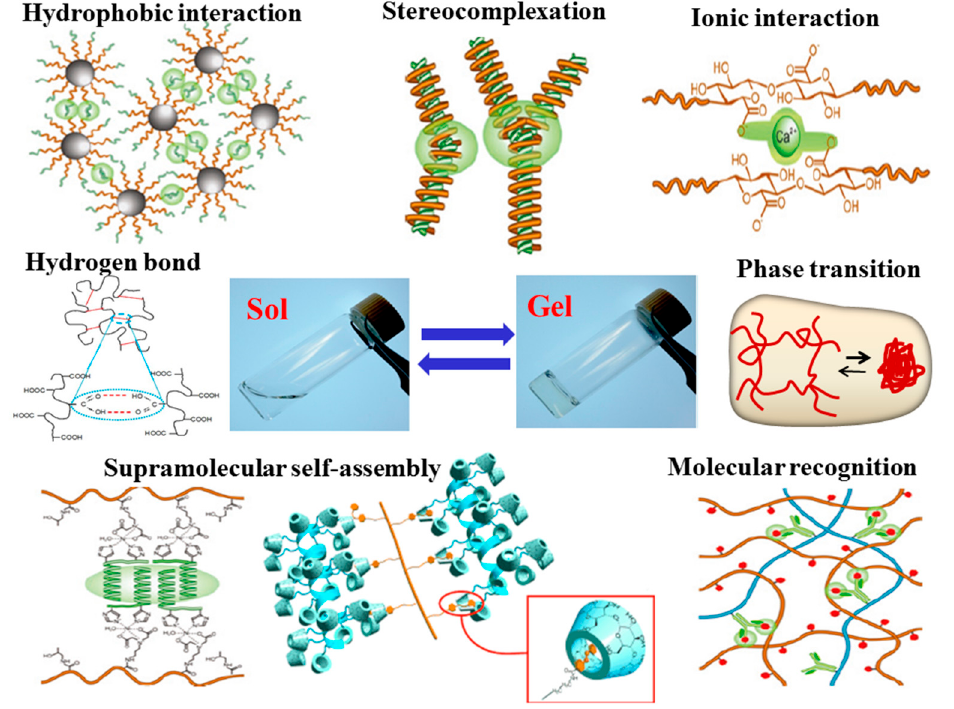
Figure 1. Schematic illustration of methods for formation of physically crosslinked